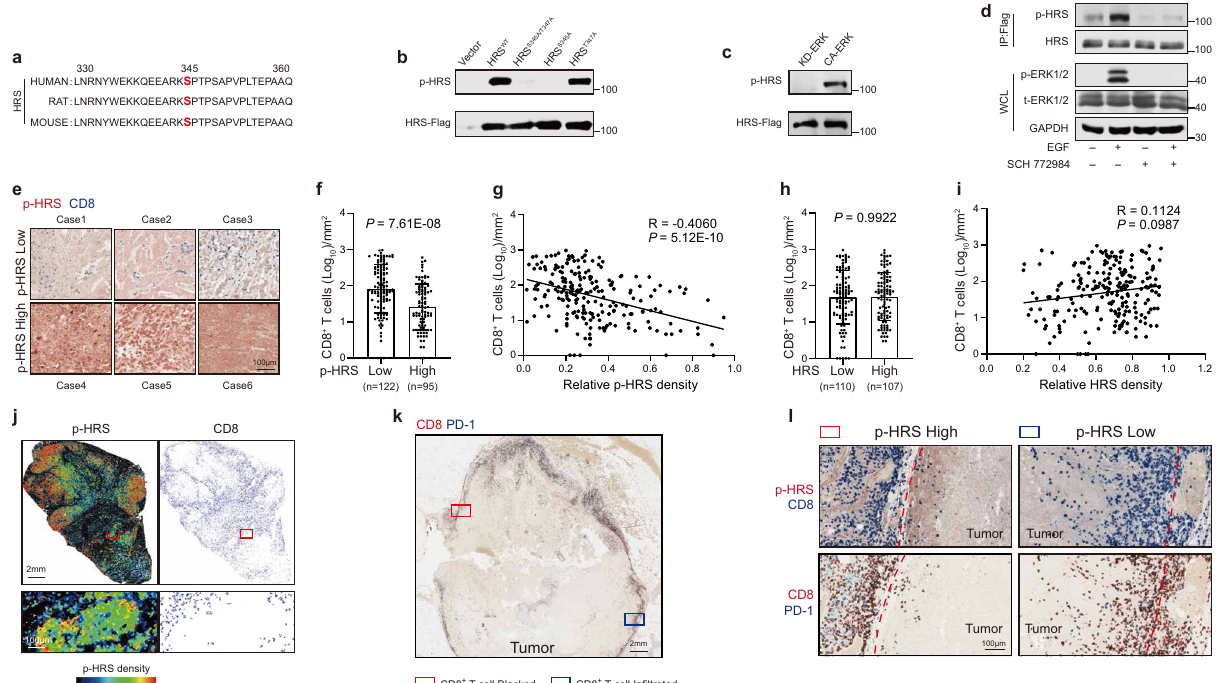
Fig. 1 Phosphorylation of HRS by ERK restricted CD8 + T cell fi ltration in melanoma. a Amino-acid sequences of HRS at Serine 345 (S345) (red) across species. b HRS was immunoprecipitated from HEK 293 T cells expressing Flag-tagged wild-type HRS or indicated mutants. HRS phosphorylation was determined using the anti-ERK phospho-substrate antibody. c Puri fi ed Flag-tagged HRS was incubated with constitutively-activated ERK2 ( “ CA-ERK2 ” ) or kinase-dead mutant ERK2 ( “ KD-ERK2 ” ) in vitro and the phosphorylation was determined by anti-ERK phospho-substrate antibody. d Cells expressing Flag- tagged HRS were serum-starved overnight and then treated with EGF in the presence or absence of ERK inhibitor SCH772984. HRS-Flag protein was then immunoisolated from cell lysates, and phosphorylation of HRS-Flag was detected with anti-ERK phospho-substrate antibody. As a control, EGF treatment also activated ERK as shown by its phosphorylation ( “ pERK1/2 ” ). Total ERK levels were also shown ( “ t-ERK ” ). GAPDH was used as a loading control. e Representative IHC images of melanoma tissues co-stained with antibodies against HRS phosphorylated at S345 ( “ p-HRS ” ) and CD8. Tumors expressing low (upper panel) and high (lower panel) levels of pHRS are shown. Scale bar: 100 μ m. f The numbers of CD8 + TILs in melanomas from patients with TILs with p-HRS levels in malignant melanoma tissues ( n = 217). h The numbers of CD8 + TILs in melanomas obtained from patients with different levels of